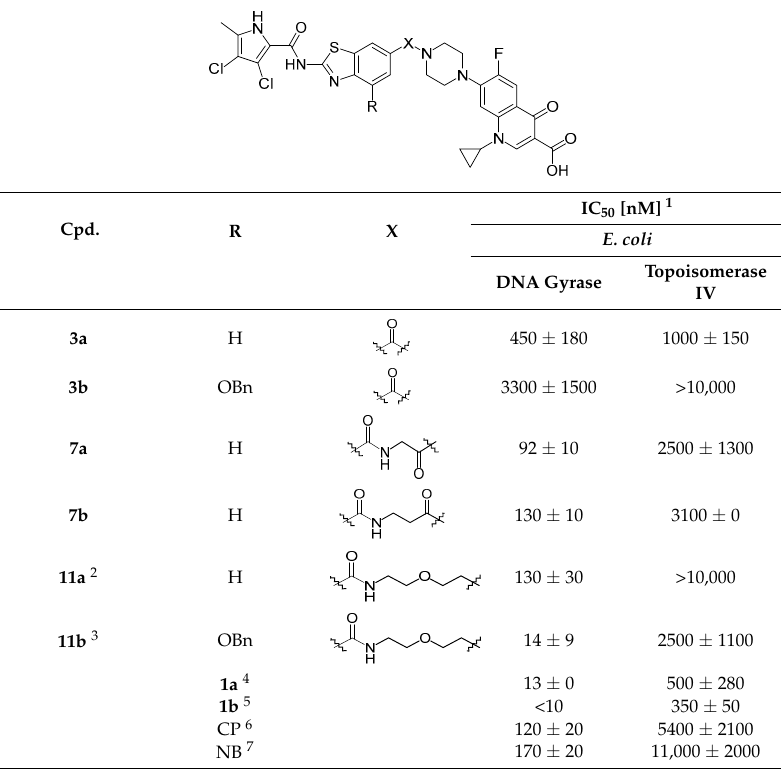
Cpd. Cpd. R X Cpd. R X Cpd. X Cpd. Cpd. Cpd. Cpd.